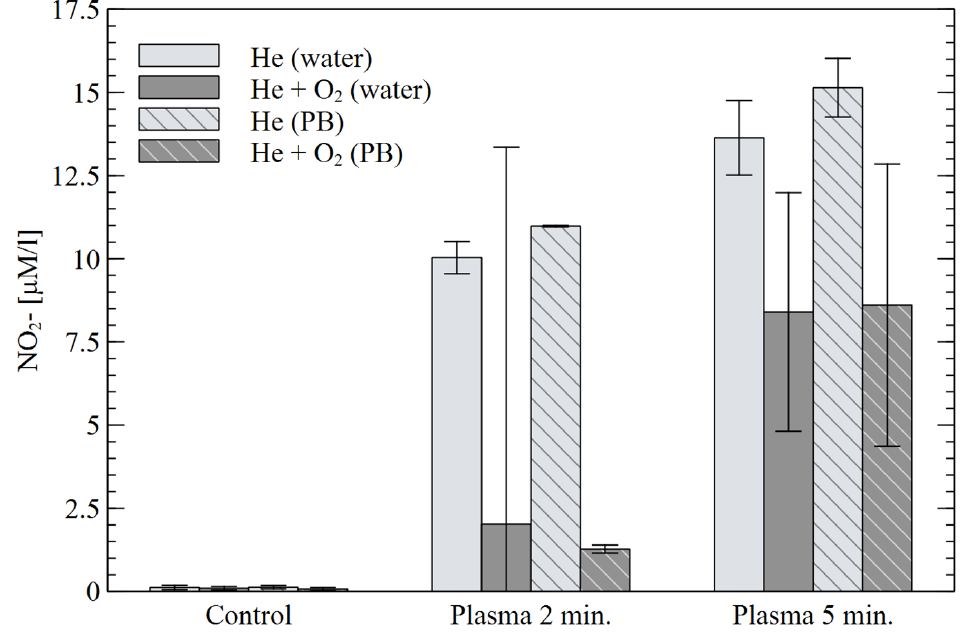
Figure 9. Concentration of NO 2 − in water and PB for different plasma treatment times.